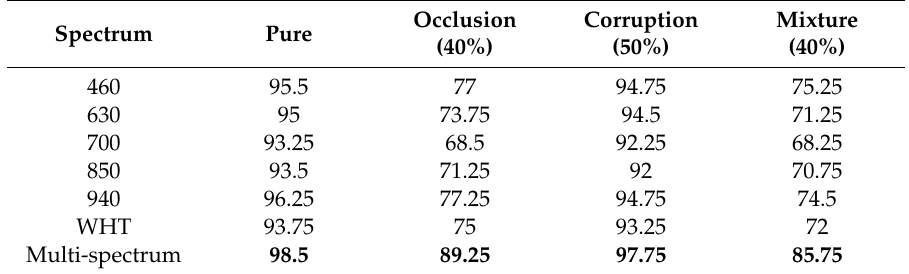
Table 4. Recognition rates (%) of multispectral and single-spectrum palmprint recognition on the CASIA